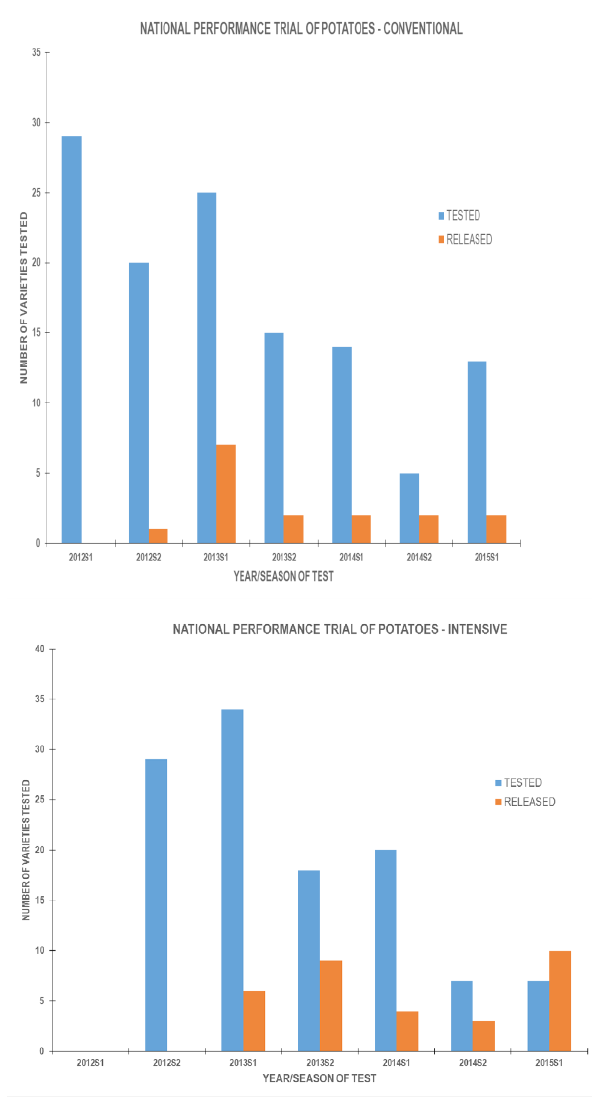
Figure 1: Potato varieties tested and released in 2012-2015